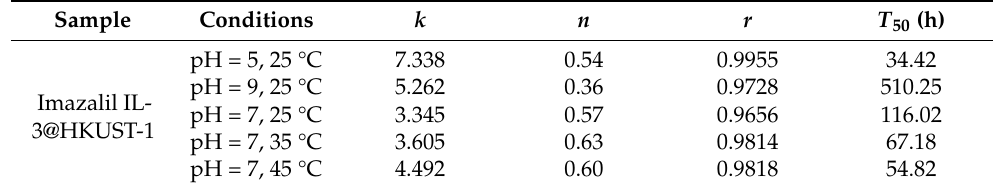
Table 4. Constants from fitting the generalized model, M t /M 0 = kt n , to the release data of imazalil from imazalil IL-3@HKUST-1 in different pH